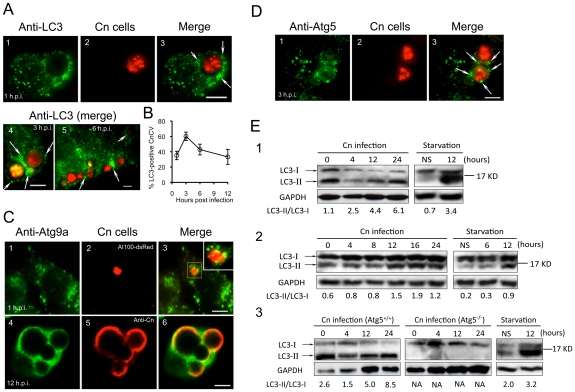

Cryptococcus neoformans interactions with Atg proteins during infection.Murine J774.A1 or RAW264.7 cells were seeded on 12-mm coverslips placed on the bottom of 24-well plates and then infected with Cn (AI100-dsRed) for 1 or 3 hr. At 3 h.p.i., the infected cells were wash three times and then continuously incubated in fresh medium supplemented with 20 µg/ml fluconazole. At the indicated time points, the infected cells were fixed and prepared for immunofluorescence microscopy using antibodies directed against mouse proteins LC3 (A, J774.A1 cells) or Atg9a (C, RAW264.7 cells. Inset in C3: a magnified section shows Atg9a in close apposition to CnCvs during an early stage of infection) and Atg5 (D, J774.A1 cells). Regions of colocalization appear yellow in the images (C3 and C6). CnCVs surrounded by host proteins are indicated by white arrows. Scale bars indicate 5 µM. Images were taken from a representative experiment of at least three independent experiments. B. Quantification of Cn cells that resided in host LC3-positive compartments during a time course of infection. At each time point, the percent of total cells analyzed in which LC3 was tightly associated with CnCvs was calculated and plotted as a function of time. Data represent the means ± SD from at least three independent experiments. For each experiment, at least 300 internalized or replicative Cn cells were analyzed. E. Induction of LC3-I to LC3-II processing by Cn infection. Murine J774.A1 (E1), RAW264.7 (E2) macrophages or MEFs (E3) were infected with Cn strain AI100-dsRed or cultured in serum free DMEM (starvation) for 12 hr. At the indicated time points, Cn infected and serum starved cell samples were collected, and subjected to immunoblotting analysis using antibodies directed against mouse LC3. NS = non-starved. Representative images were taken from a single experiment. Three independent experiments gave similar results.